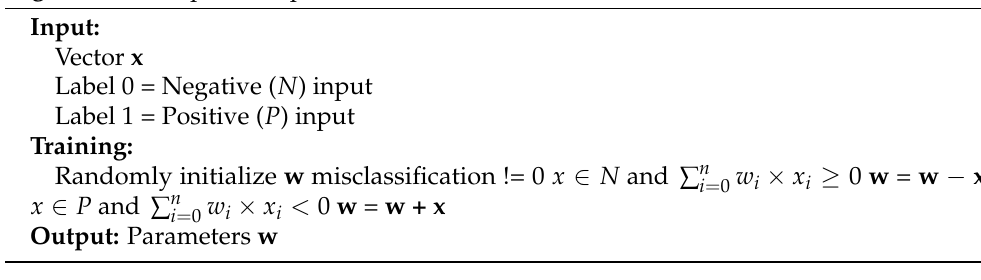
Algorithm 3 Simple Perceptron